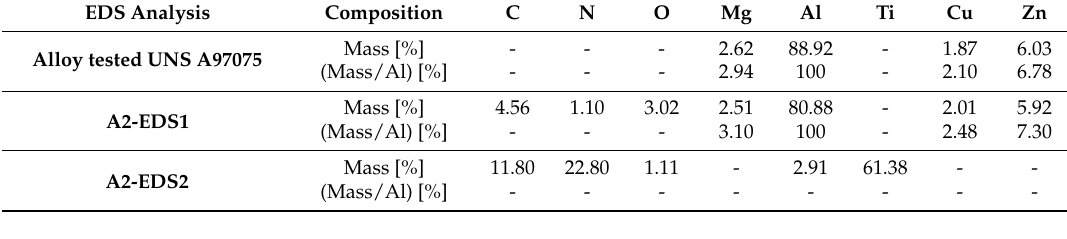
Figure 10. SEM image from A2 (the analyzed points are marked). Table 5. Composition from EDS analysis (A2).